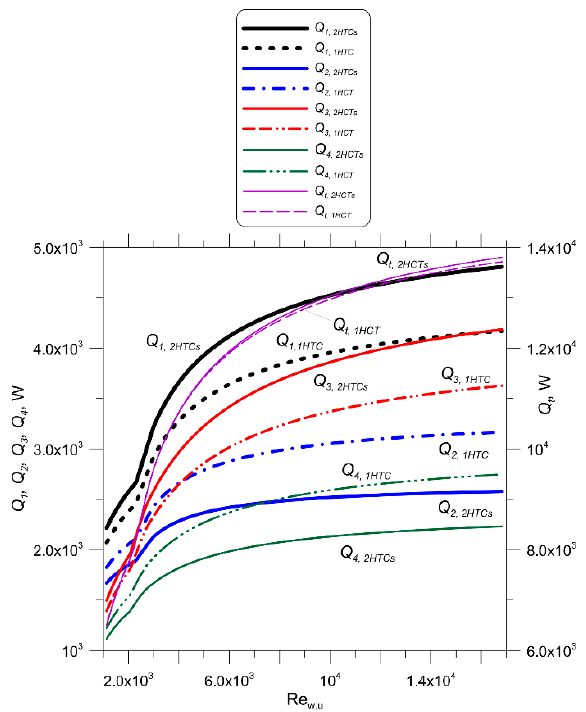
Figure 10. Comparison of thermal capacities of specific pipe rows and the whole-car radiator supposing that HTC on the air-side is uniform in both pipe rows with the corresponding thermal capacities obtained for di ff erent HTCs in the first and second pipe rows; w 0 = 2.27 m / s, T (cid:48) = 70.56 ◦ C; Q = 1, ... ,4: thermal output of the specific pipe rows (Figure 1) supposing the same Equation (32) for the Nusselt number on the air-side throughout the radiator, Q i ,2 HTC , i = 1, ... ,4: thermal outputs of individual pipe rows (Figure 1) for di ff erent equations for the air-side Nusselt in both pipe rows; Equation (30) was used for the first row of tubes and Equation (31) for the second row, Q t ,1 HTC : car radiator output calculated using Equation (32) for all rows of pipes, Q t ,2 HTC : car radiator output calculated using di ff erent heat transfer correlations for the first and second tube rows.